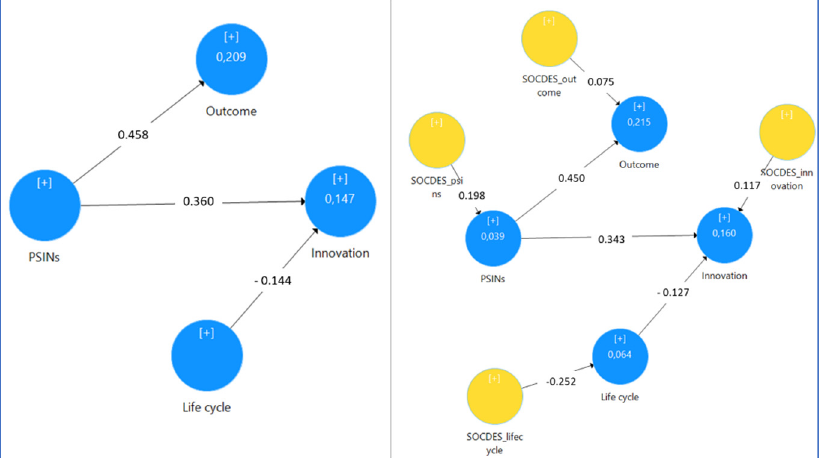
Figure 6. ( Left ) Original HOC model paths. ( Right ) Application of the Construct Level Correction (CLC) Approach over the HCM model and CLC-estimated paths.